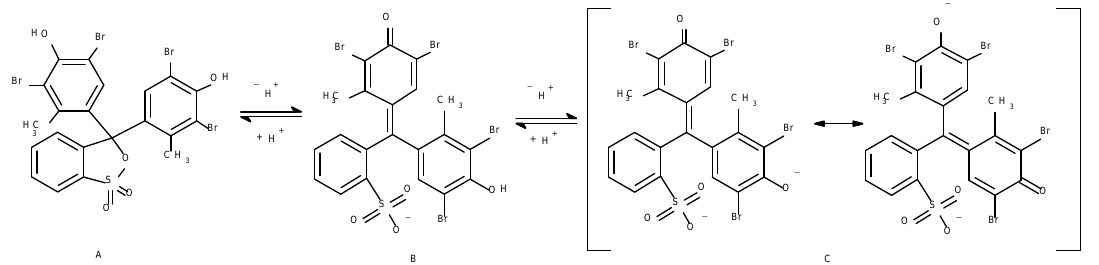
Figure 3. General colour changing mechanism of Bromocresol green. The neutral structure A is observed in very acidic solutions or in powder, the relevant colour change originates from a deprotonation from the single anionic form B to a double anion C .